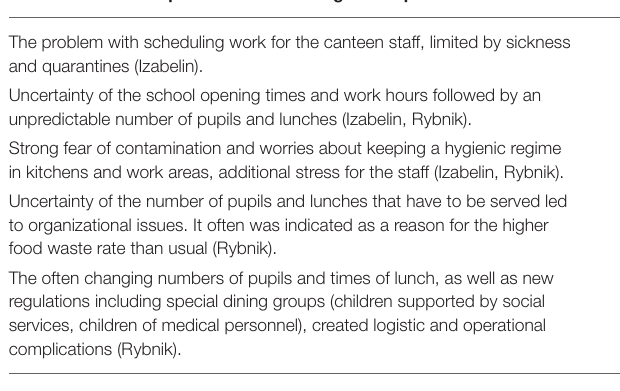
TABLE 4 | Challenges and positive developments during COVID-19 in Finnish municipalities. COVID-19 driven reported main challenges and problems